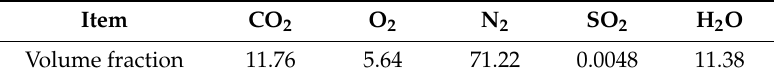
Table 5. Major composition of the cleaned flue gas (%).